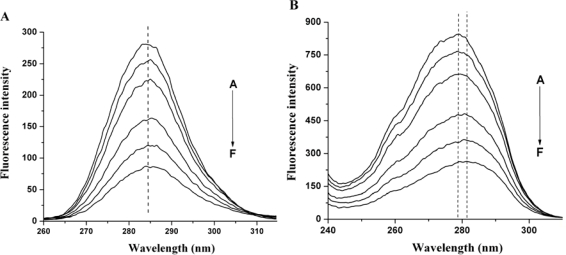
Synchronous fluorescence spectra of HSA in the presence of nC60. (A) Δλ = 15 nm; (B) Δλ = 60 nm. HSA concentration is 20 μM. The concentration of C60 (from A to F) was 0, 1.41, 2.83, 5.66, 8.48, 11.30 μM, respectively.